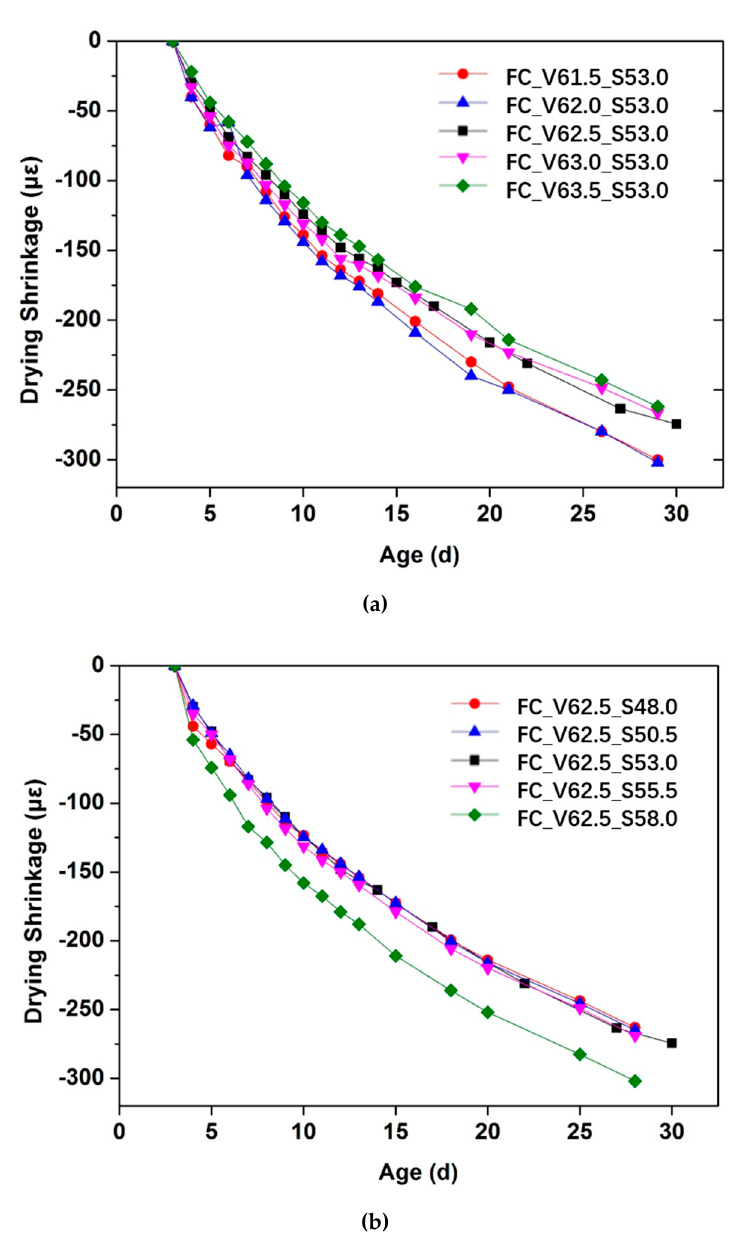
Figure 9. Influence of aggregate volume fraction ( a ) and sand to total aggregate volume ratio ( b ) on drying shrinkage of fluid concrete mixtures.